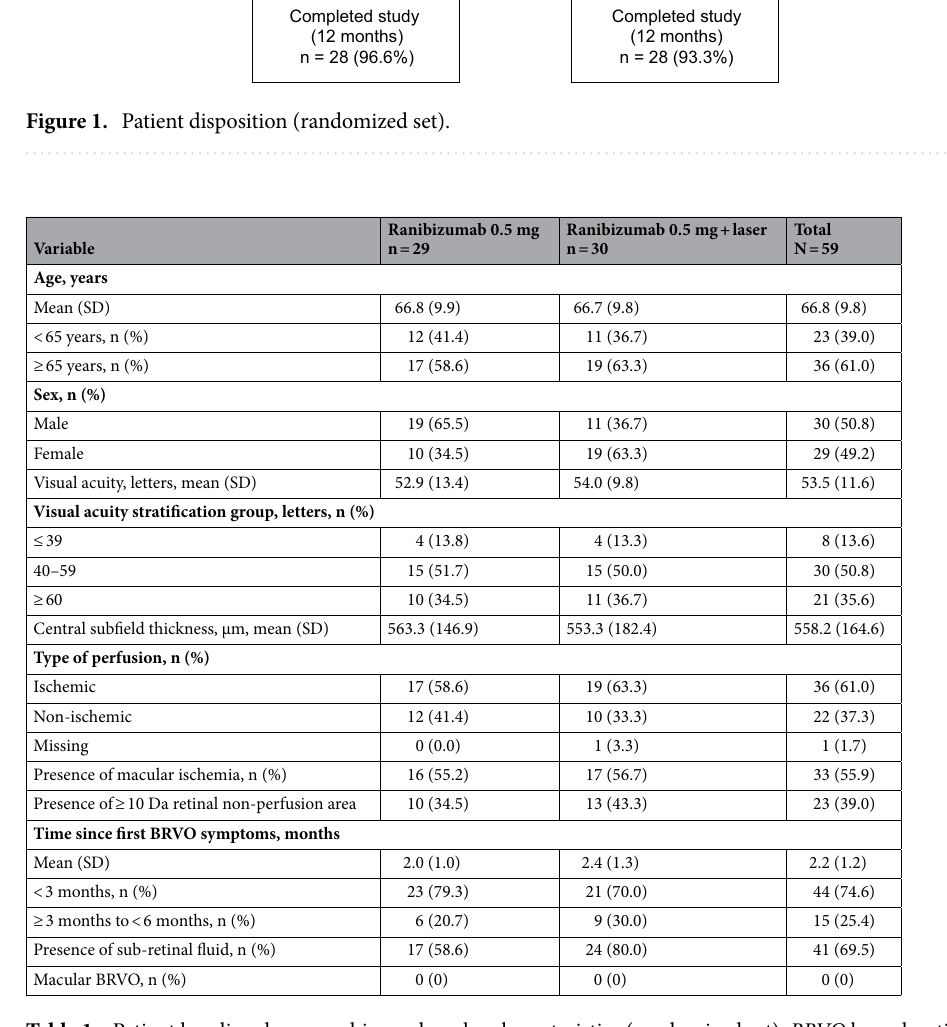
Table 1. Patient baseline demographics and ocular characteristics (randomized set). BRVO branch retinal vein occlusion, SD standard